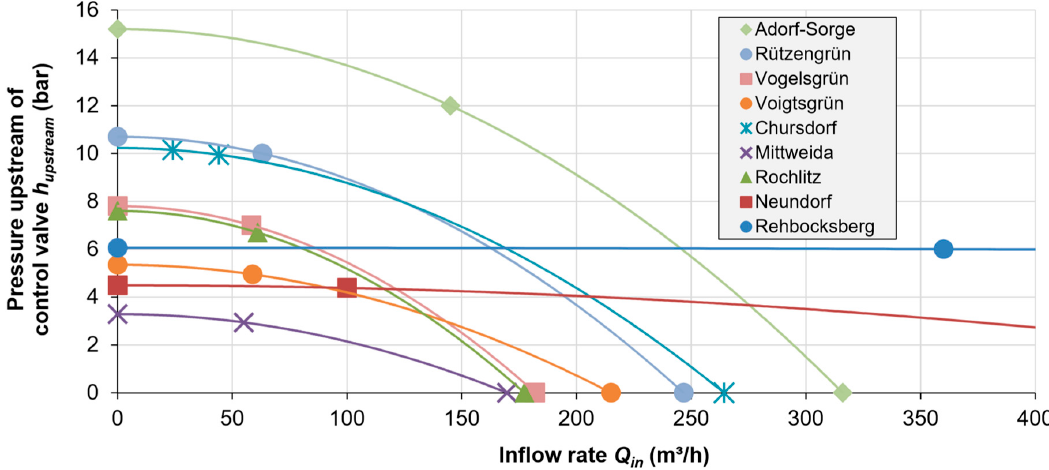
Figure 12. Overview of the hydraulic characteristic curves for all nine sites analyzed.